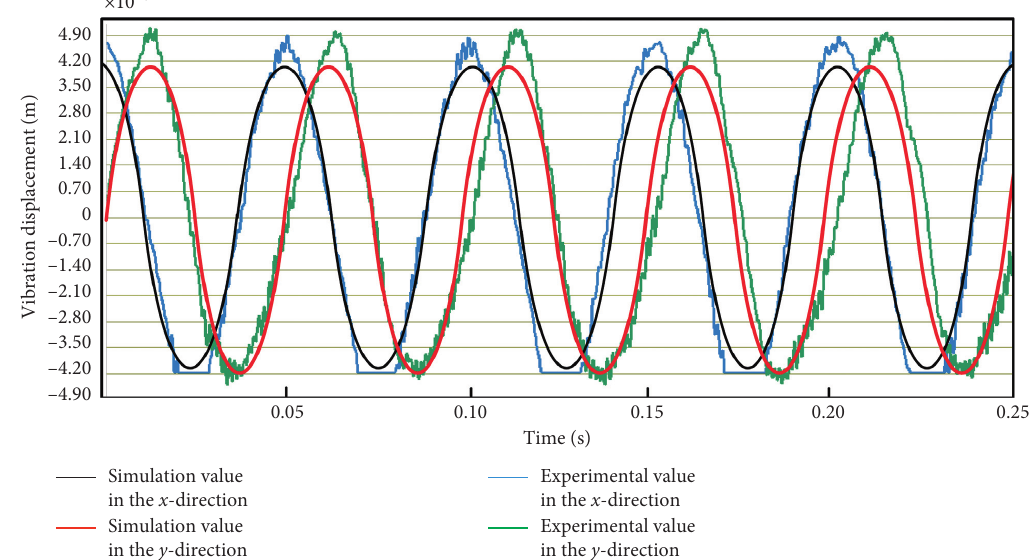
Figure 15: Comparison of experimental values and simulated values of radial vibration displacement at 900 r/min.